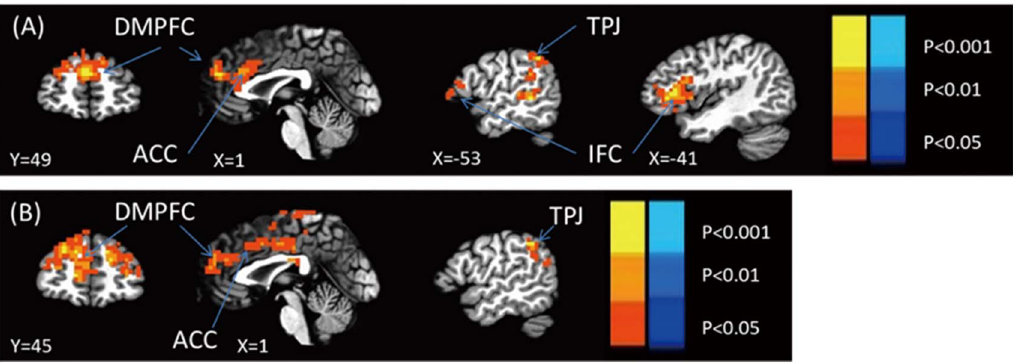
Figure 2. Contrasting brain activation patterns elicited by different name types. (A) SN . UN; (B) MN . UN.